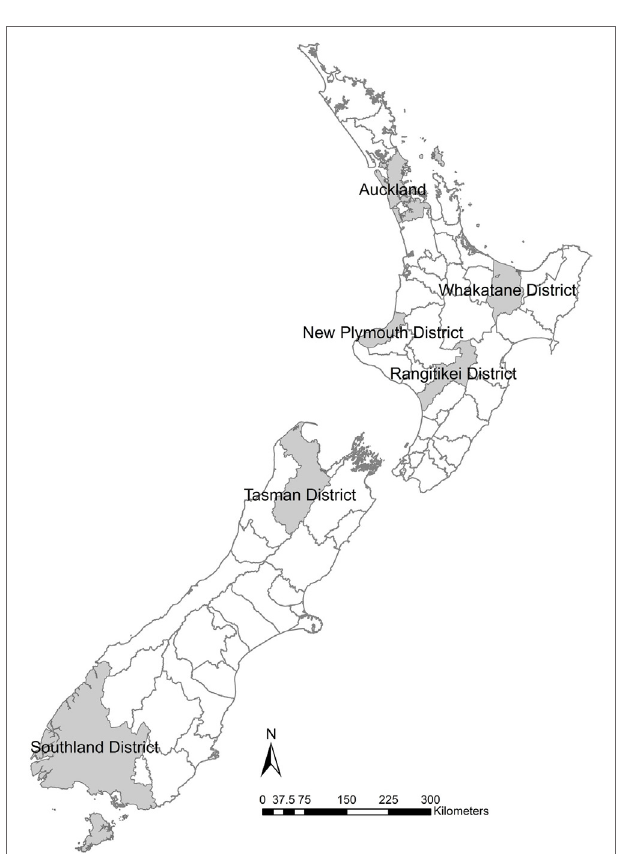
FigUre 1 | Six New Zealand territorial local authorities selected for locations of simulation models to examine the effects of variation in herd size in the within-herd spread disease model of foot-and-mouth disease, Australian Animal Disease model.